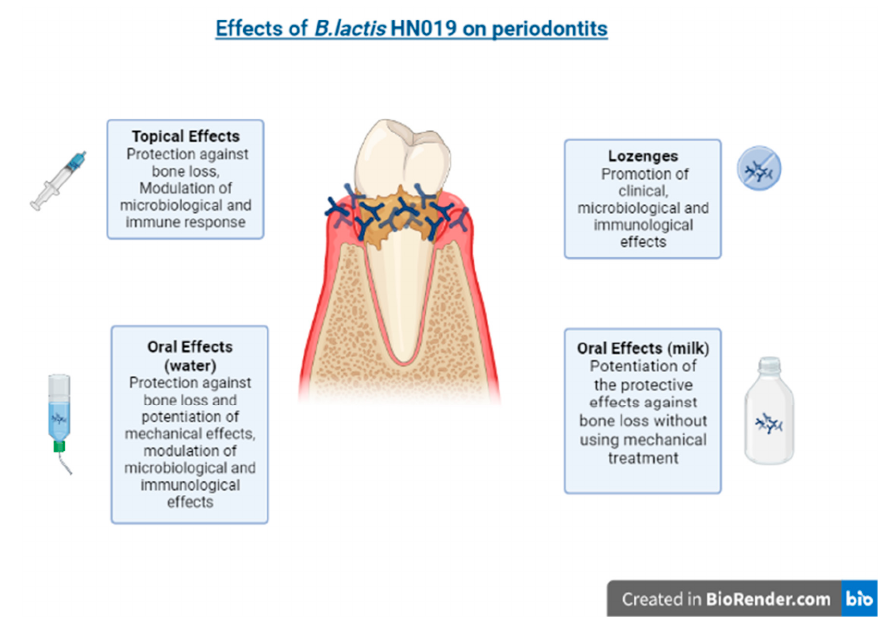
Figure 2. The effects of B. lactis HN19 on periodontitis.